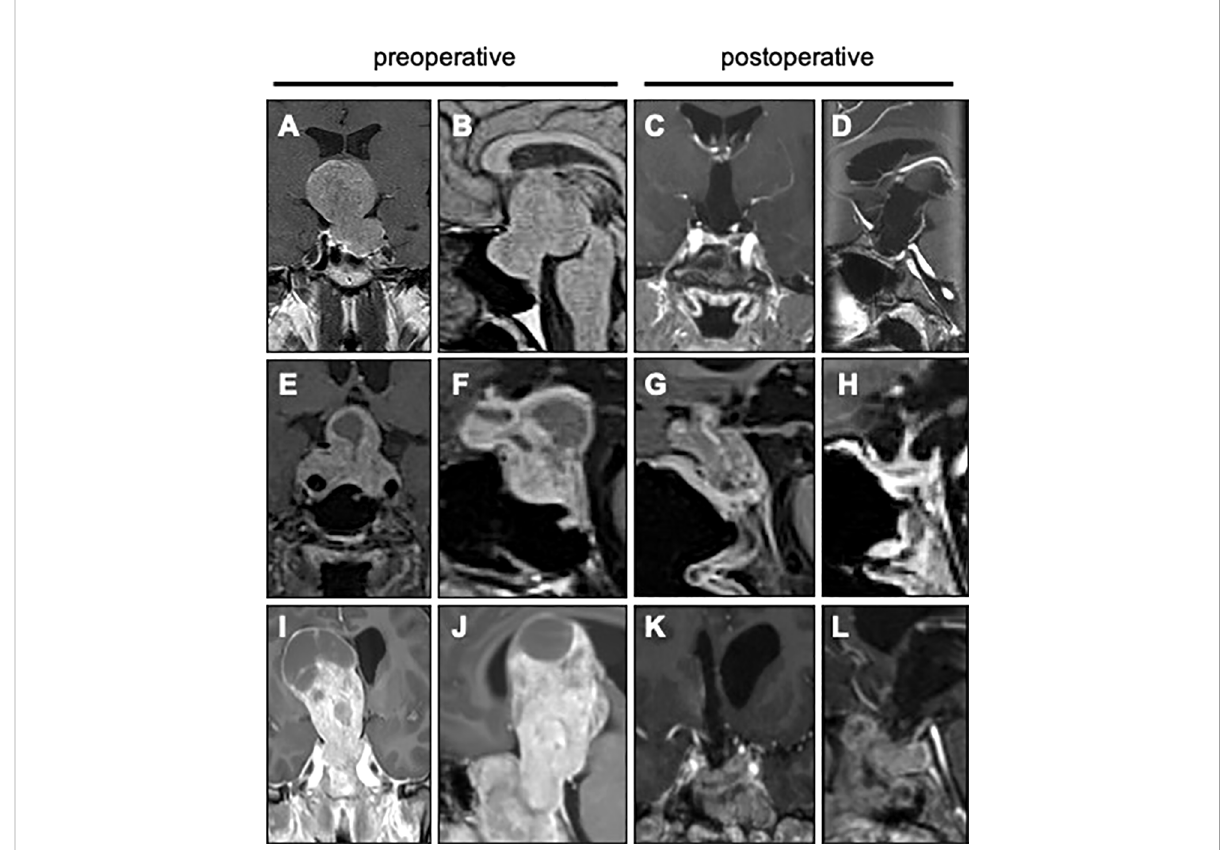
FIGURE 2 Surgical resection of giant pituitary tumors Pituitary MRI from three patients are presented, before and after surgery (gadolinium-enhanced T1 weighted coronal and sagittal images). (A-D) Giant pituitary tumor with a “ narrow neck ” pattern, resected with an extended endoscopic endonasal approach. (E-H) Giant pituitary tumor with transdiaphragmatic subfrontal extension, resected in two steps with combined endoscopic endonasal and microscopic transcranial approaches. (I-L) Giant pituitary tumor with a huge suprasellar expansion extending beyond the Monro foramen, resected with a transfrontal transcranial